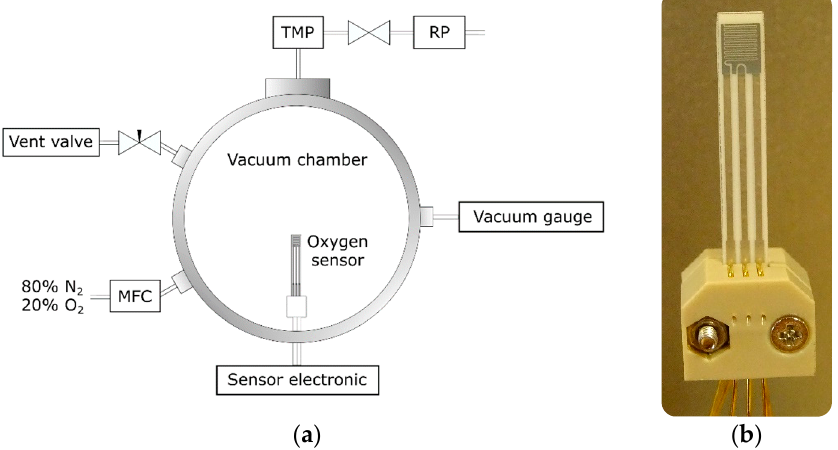
Figure 2. ( a ) Schematic diagram of the vacuum chamber for sensor characterization; ( b ) sensor mounted on the PEEK-adapter and contacted with the gold-coated wires.